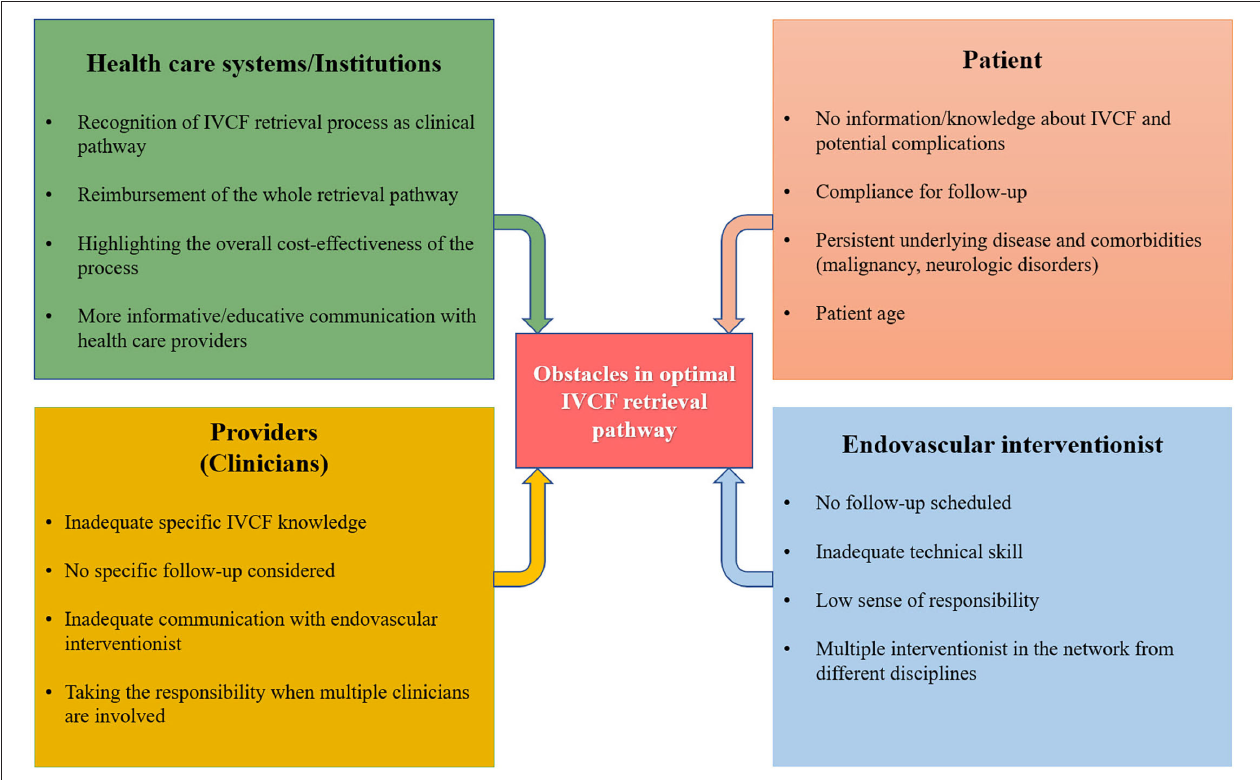
FIGURE 2 | Brief review of the obstacles in IVC filter retrieval